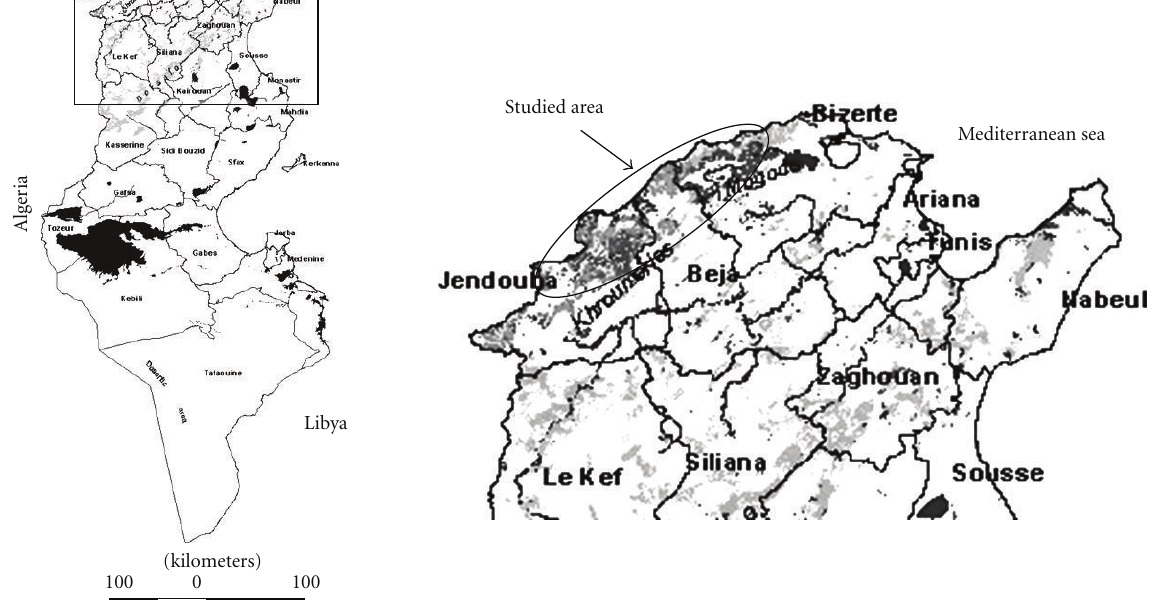
Figure 1: Map showing the studied area of Pinus pinea plantations in northwest of Tunisia.